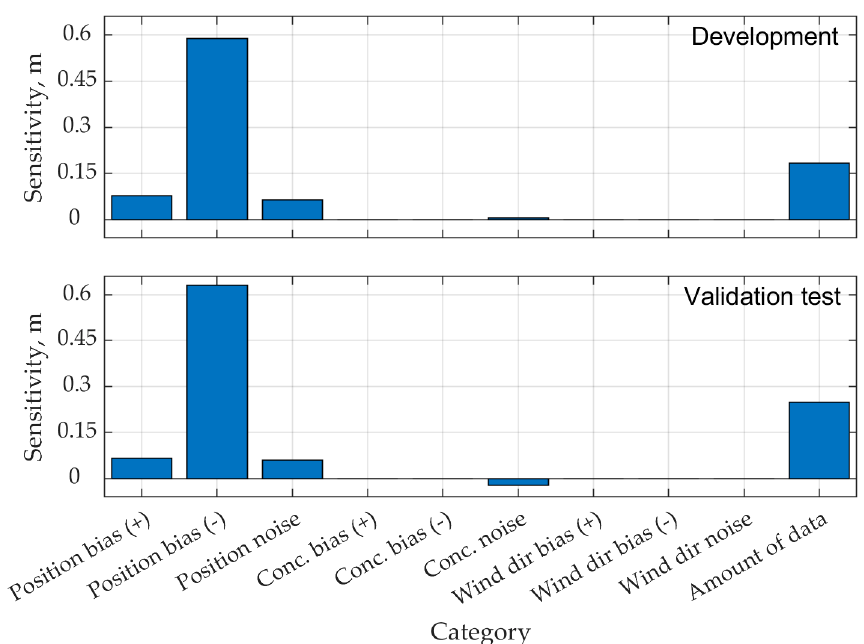
Figure 11. Sensitivity analyses for the maximum-based localization method. The y -axis here represents the difference in mean error between the data with and without added noise. Position bias: +/ − 0.9 m offset to both x and y; position noise: added normally distributed noise ( μ = 0 m, σ = 0.3 m); concentration bias: ×/÷1.05x, concentration noise: added normally distributed noise ( μ = 0 ppm-m, σ = 5 ppm-m), wind direction bias: +/ − 25 degrees, wind direction noise: added normally distributed noise ( μ = 0 deg., σ = 5 deg.), amount of data: randomly exclude half of the data.